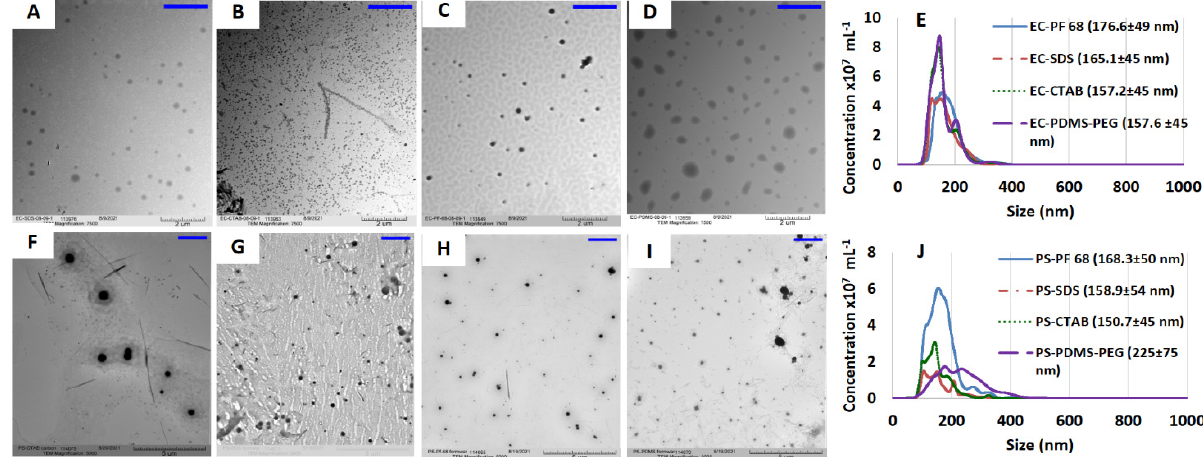
Figure 2. Transmission electron micrograph of ethyl cellulose nanoparticles stabilized with. SDS (EC ‐ SDS) ( A ), CTAB (EC ‐ CTAB) ( B ), PF ‐ 68 (EC ‐ PF68) ( C ), and PDMS ‐ b ‐ PEG (EC ‐ PDMS ‐ PEG) ( D ). ( E ) NTA analysis results of ethyl cellulose nanoparticles with average size in legend. Polystyrene nanoparticles stabilized with: SDS (PS ‐ SDS) ( F ), CTAB (PS ‐ CTAB) ( G ), PF ‐ 68 (PS ‐ PF68) ( H ), and PDMS ‐ b ‐ PEG (PS ‐ PDMS ‐ PEG) ( I ). A blue scale bar is provided in the top right of panels A–D and F–I for clarity and it represents 2.0 μ m. EC ‐ CTAB nanoparticles were found to be much smaller than all other nanoparticles and ( J ) NTA analysis results of polystyrene nanoparticles with average size displayed in the